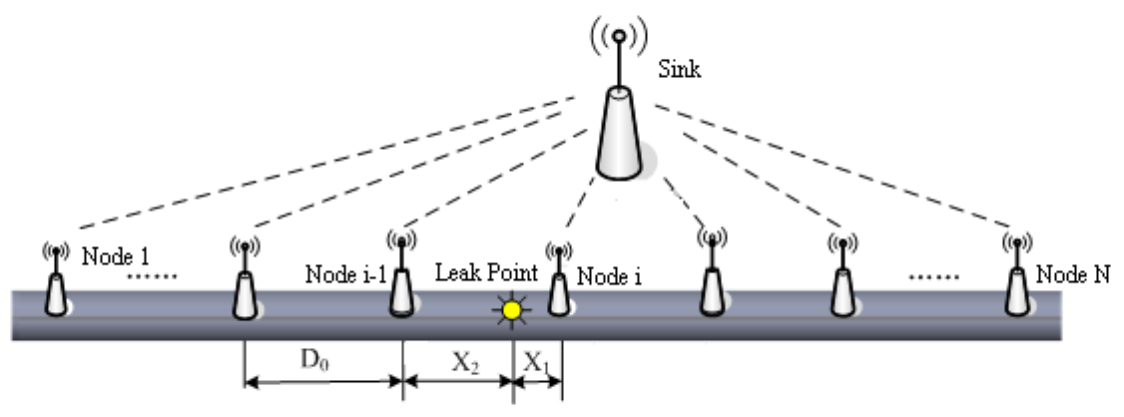
Figure 5. Multi-node integrated